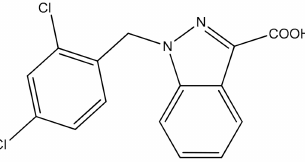
Figure 2. Structure of 1-(2,4-dichlorobenzyl)-1H-indazole-3-carboxylic acid